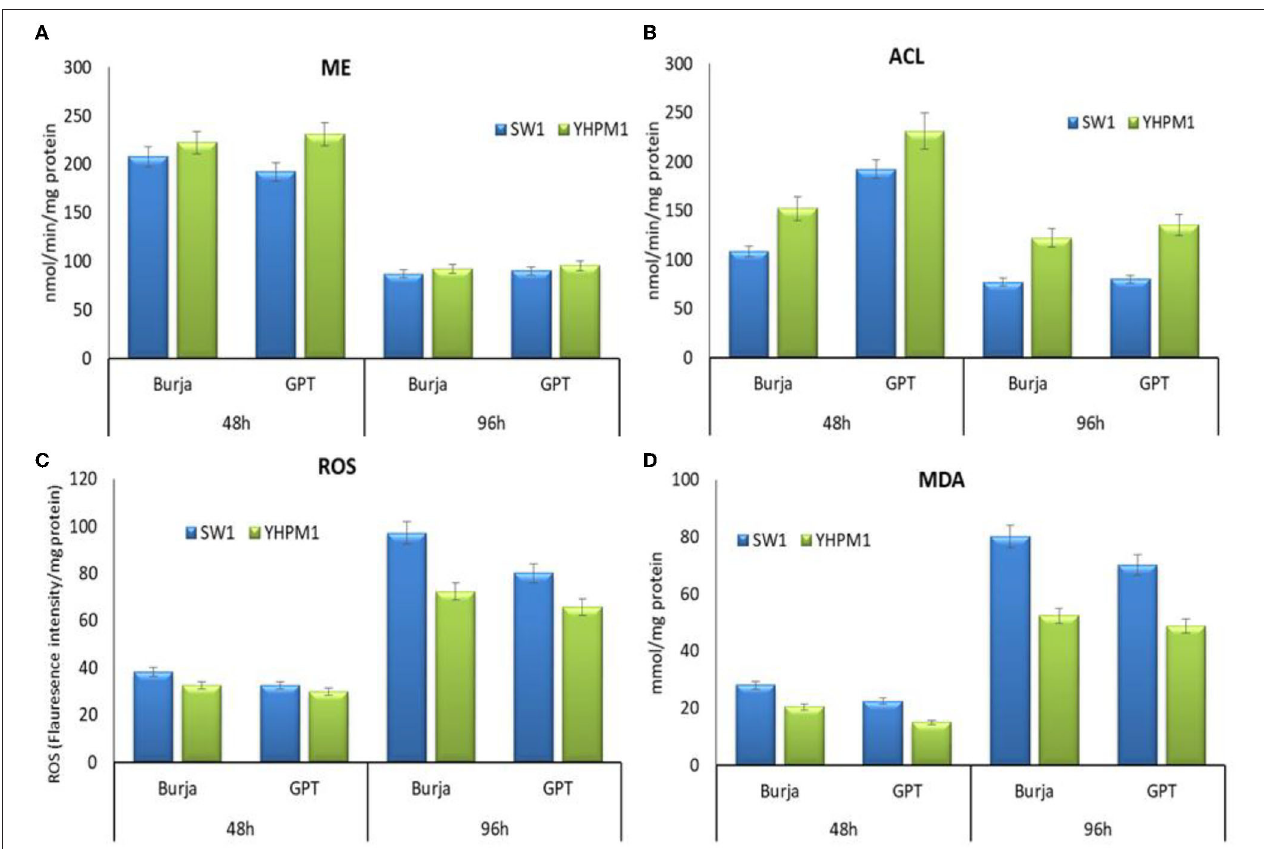
FIGURE 5 | The activity of (A) ME, (B) ACL, (C) ROS as well as (D) MDA of SW1 and YHPM1 cultured in 250mL shake flask for 48 and 96h of cultivation in Burja and GPT media. Values and error bars represent the means and the standard deviations of triplicate experiments ( n = 3).